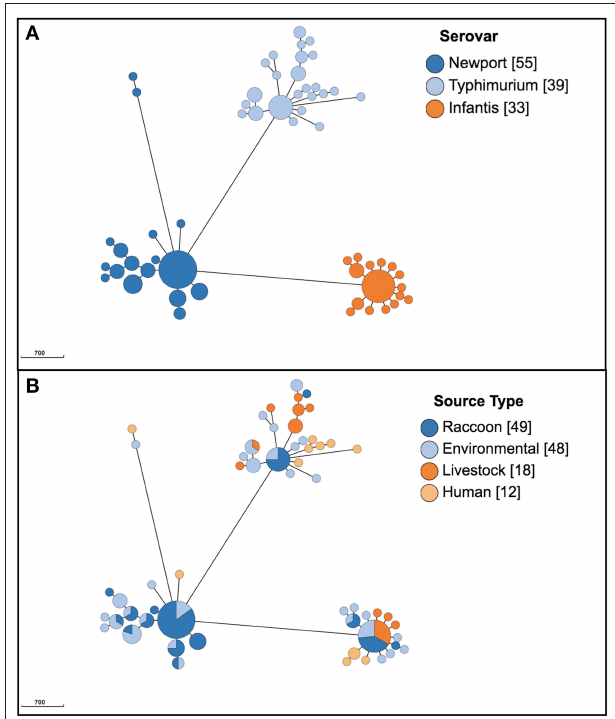
FIGURE 2 | Population structure of 127 Salmonella enterica isolates from raccoons, livestock, humans, and environmental sources in southern Ontario, Canada based on 3002-loci cgMLST scheme from Enterobase, for serovars S. Newport, S. Typhimurium, and S. Infantis (only serovars identified both in human and raccoon isolates; serovars S. Heidelberg and S. Enteritidis are not depicted here since only one raccoon isolate was identified for each, and these are reported in text). Minimum spanning tree created using k = 10 clustering threshold in GrapeTree . (A) Population structure with serovars determined using SISTR. (B) Distribution of source types. Frequency counts are in square brackets. Bubble size is proportional to the number of isolates in each cluster, and each cluster contains isolates differing at a maximum of 10 cgMLST